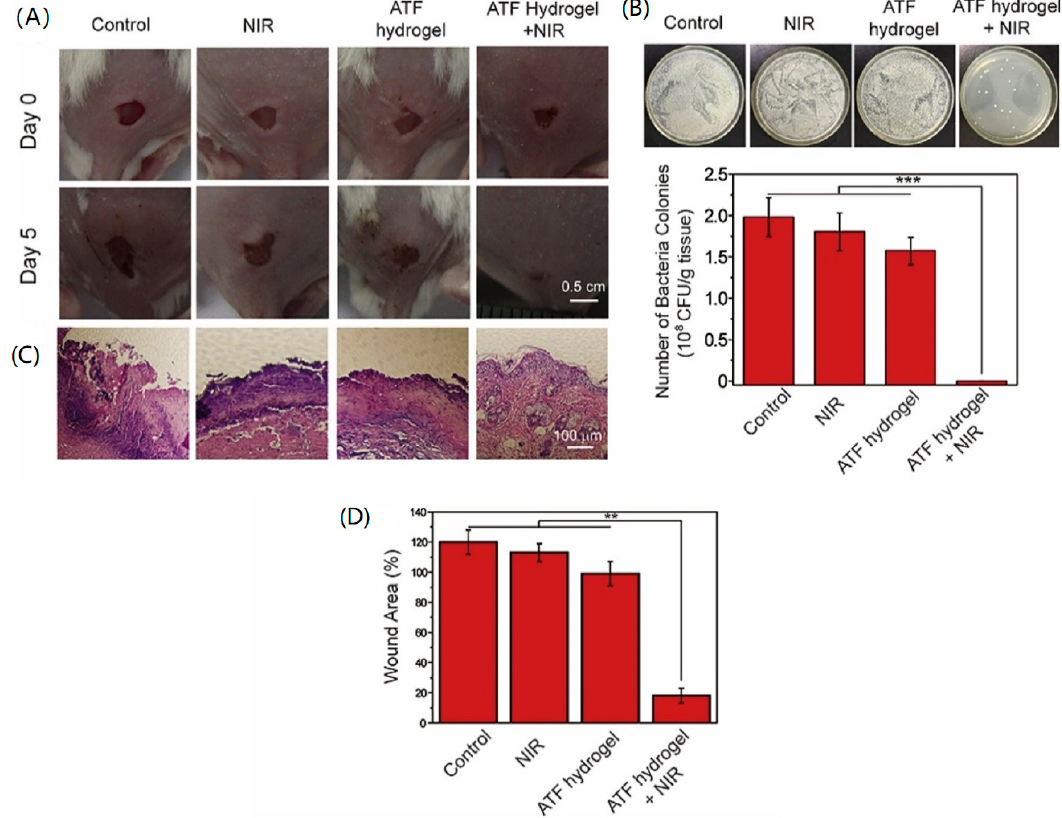
Figure 11. ( A ) Digital images of S. aureus -infected wounds of mice before treatment and after different treatments on day 5. ( B ) Digital images and histograms of S. aureus colonies derived from homogenized dispersions of the wounds of mice with different treatments, *** p < 0.001. ( C ) Digital images of hematoxylin and eosin (H&E)-stained wound sections in mice at day 5 with different treatments. ( D ) The corresponding statistical diagram of wound area healing rates of mice in ( A ). Data are presented as the mean ± SD from six parallel experiments per group ( n = 6). ** p < 0.01. Reproduced from [92], with permission from Elsevier, 2020.